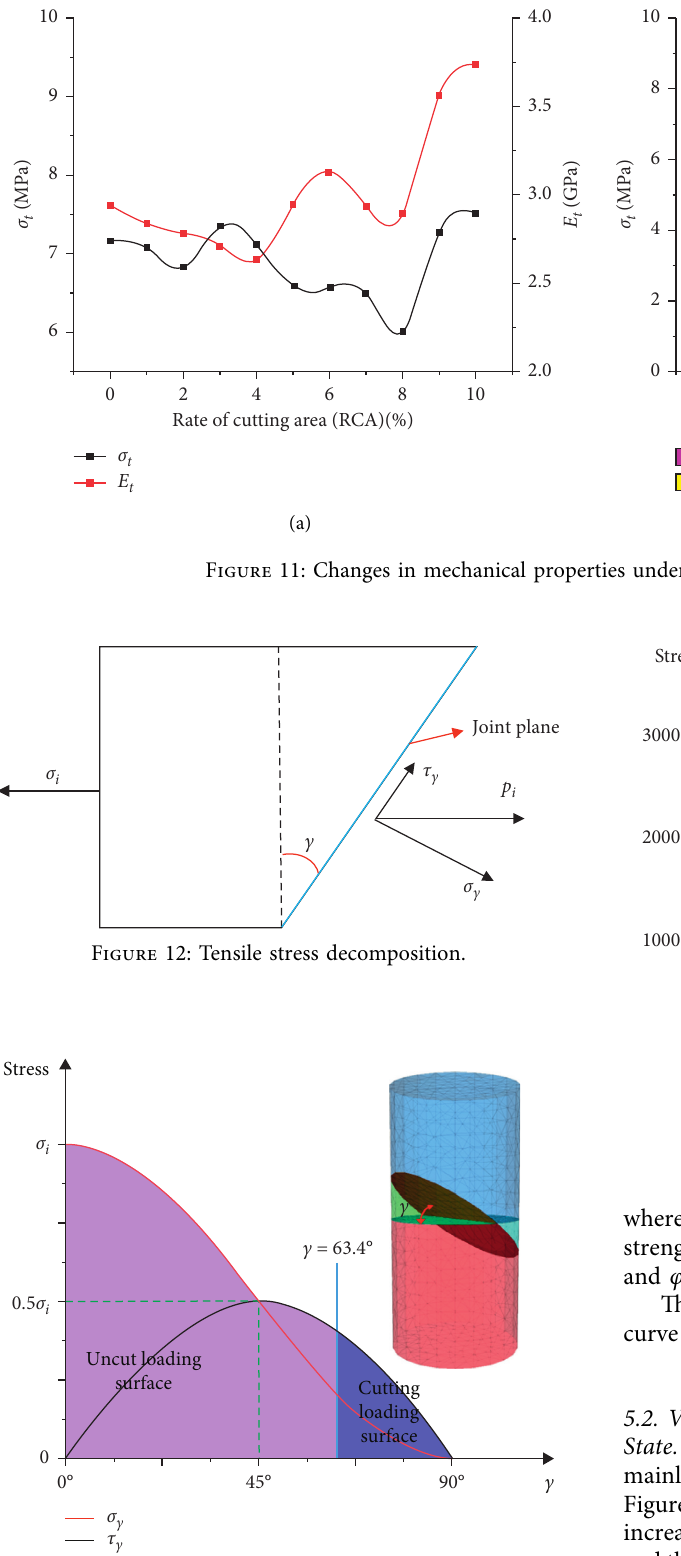
Figure 13: Variation in σ